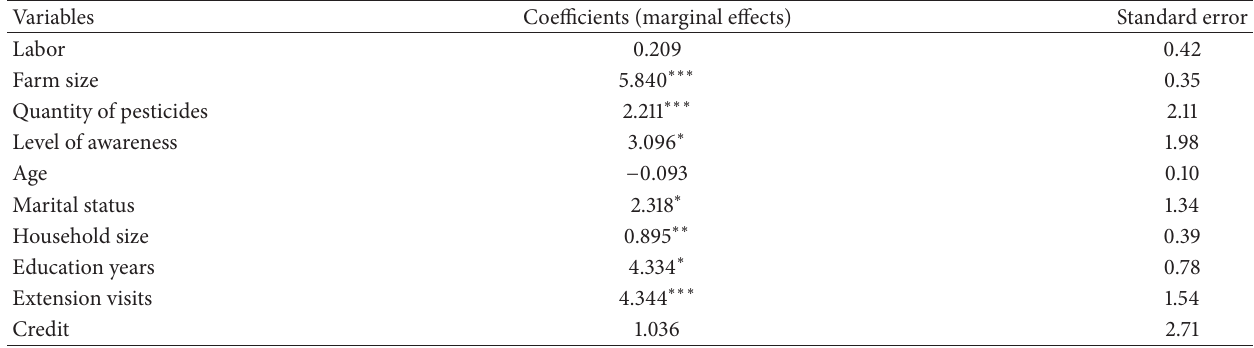
Table 6: Multiple linear regression results: level of awareness as driver of maize